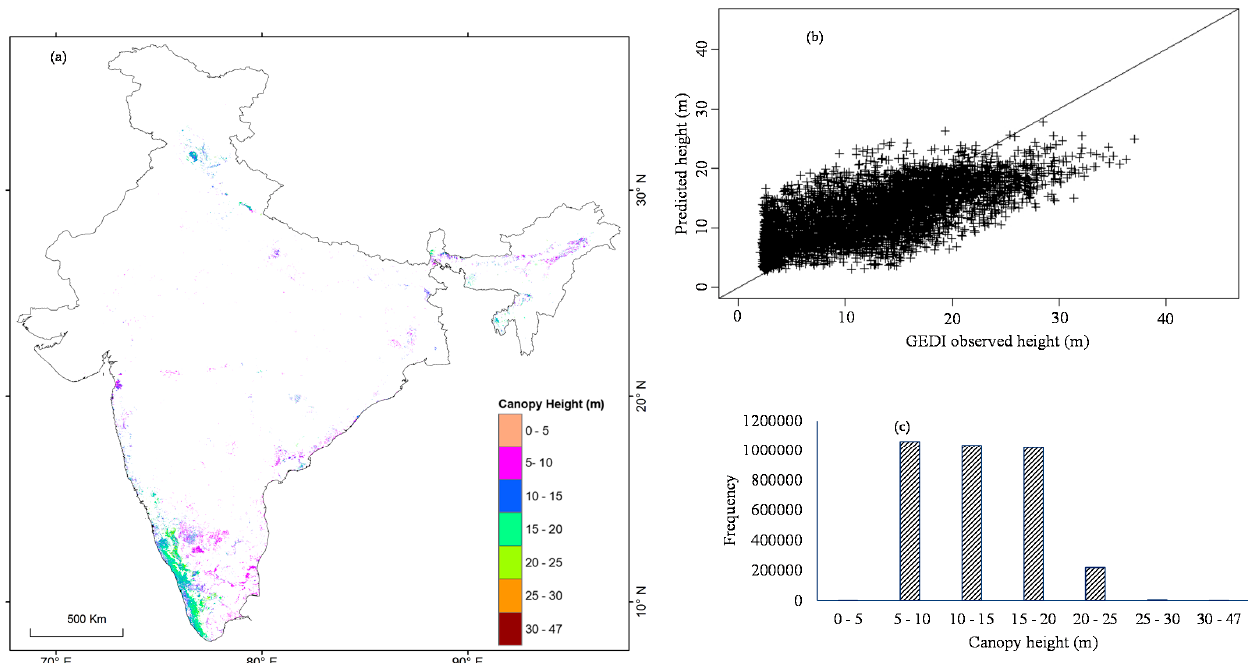
Figure 6. ( a ) GEDI predicted forest canopy height map, ( b ) the RF model predicted vs. the field- estimated height plot using the GEDI data and ( c ) histograms showing the canopy height distribution for plantations.